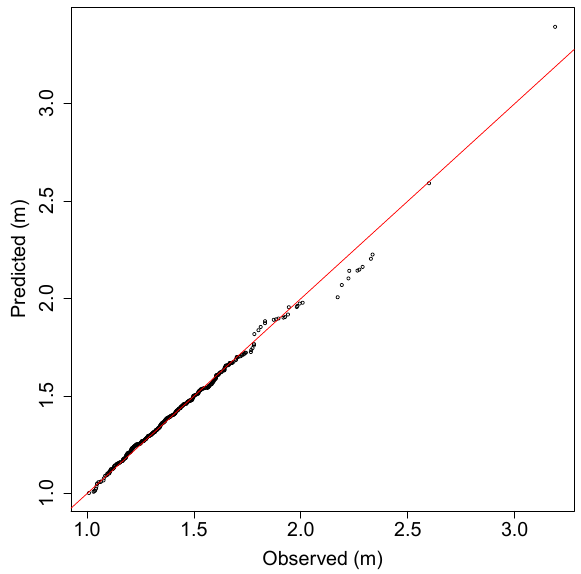
Figure 3. Q – Q plot between the observed impact ( x -axis) and the modelled impact ( y -axis) from the regression model (Eq.